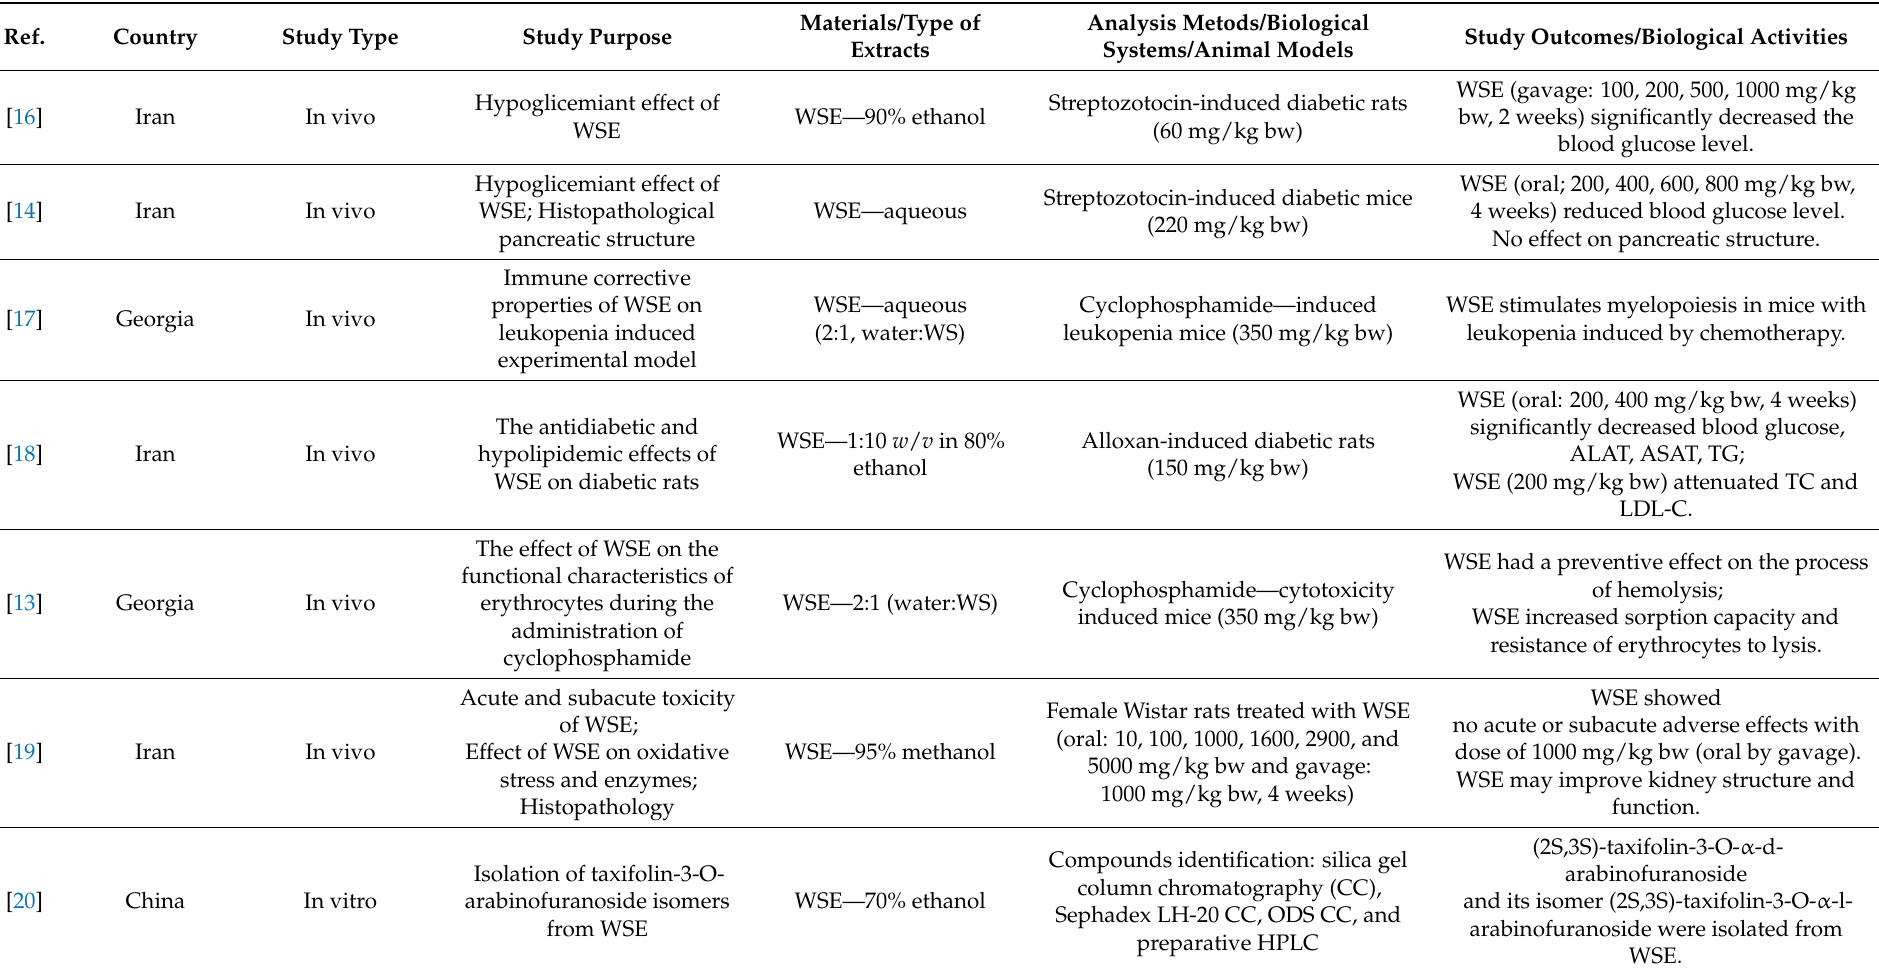
Table 1. Characteristics of the selected